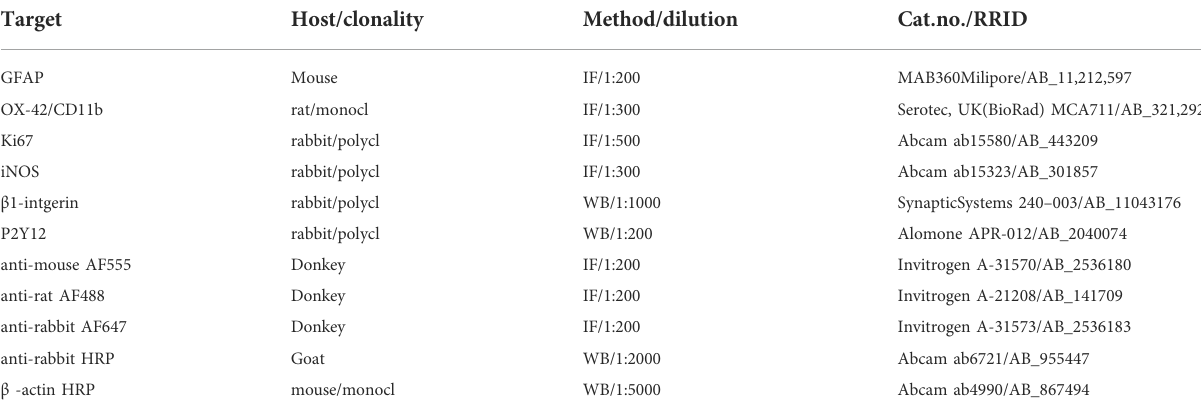
TABLE 1 List of primary and secondary antibodies